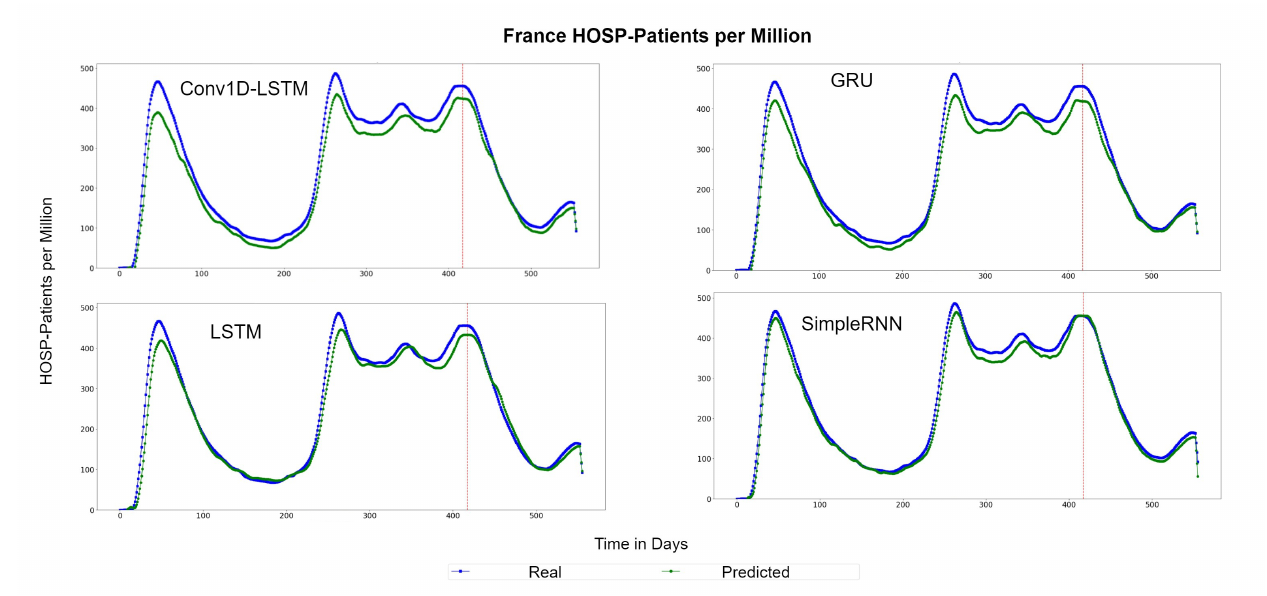
Figure 20. France HOSP-Patients per million real (blue line) and predicted (green line) values for each method, using the training, validation, and test datasets. The red line divide the train-validation (right size) and the test (left side) datasets.